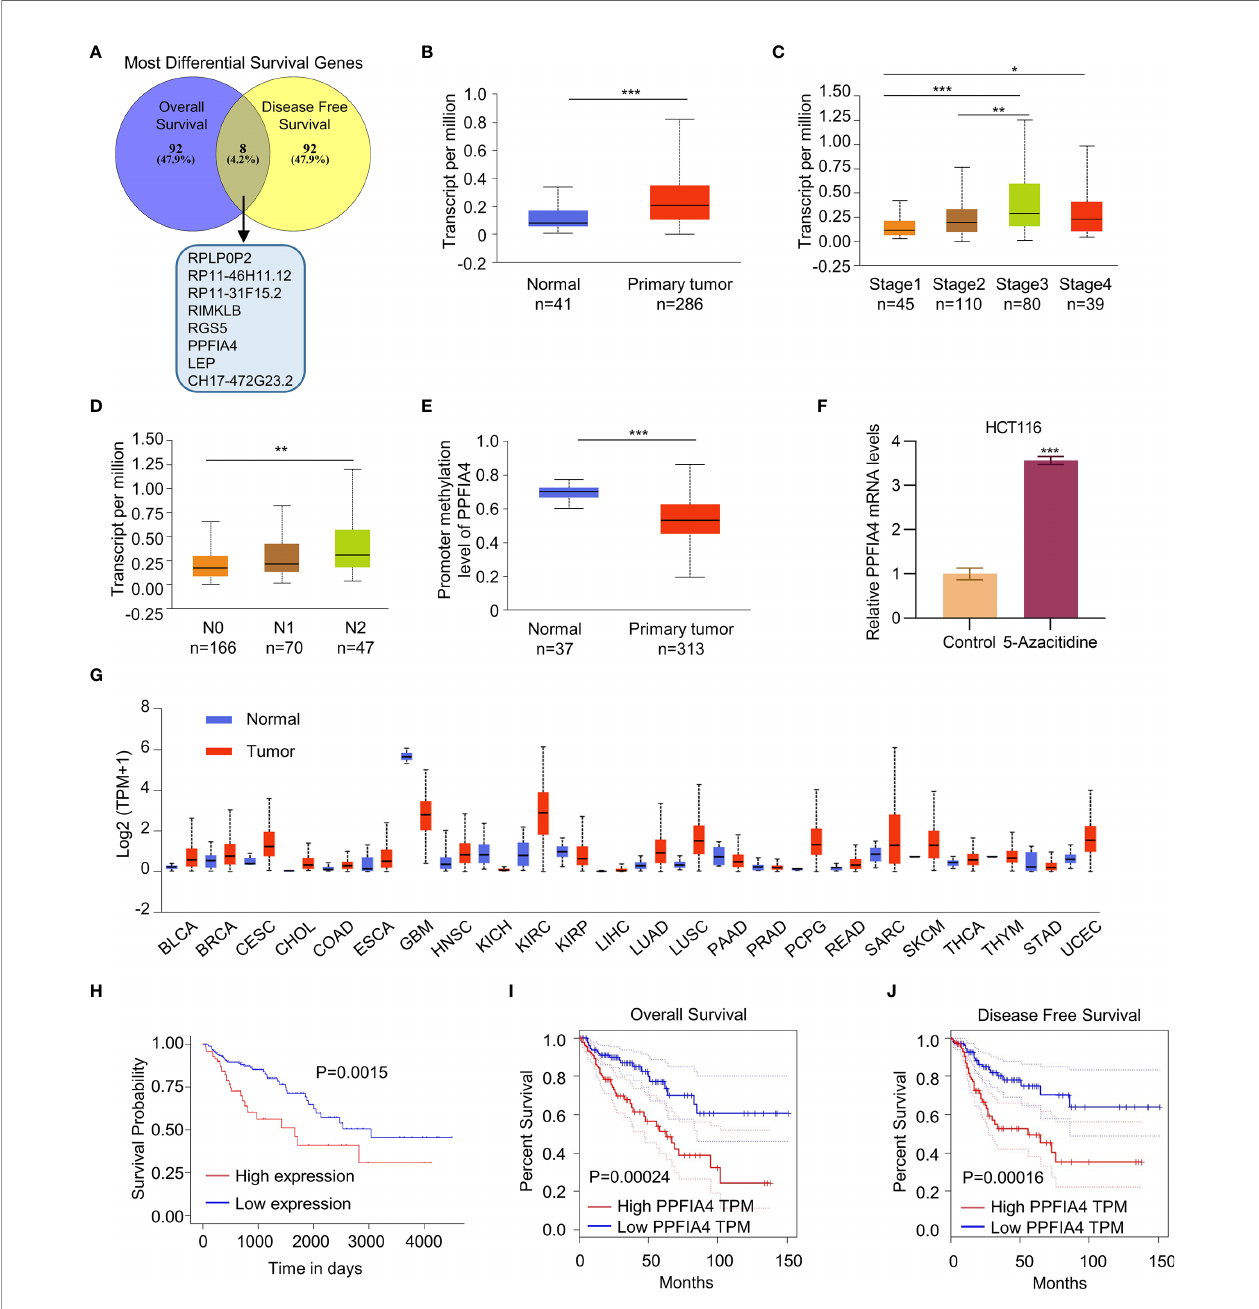
FIGURE 1 | PPFIA4 correlates with poor survival outcomes in colon cancer. (A) Venn diagram shows the union set of Most Differential Survival Genes in colon cancer patients in GEPIA datasets. (B) Expression of PPFIA4 in normal and colon adenocarcinoma tissues in TCGA datasets. (C) Expression of PPFIA4 in colon adenocarcinoma patients with different tumor stages in TCGA datasets. (D) Expression of PPFIA4 in colon adenocarcinoma tumor tissues with different metastatic stages in TCGA datasets. (E) The methylation levels of PPFIA4 in normal and colon adenocarcinoma tumor tissues were analyzed in TCGA datasets. (F) The mRNA levels of PPFIA4 in HCT116 cells treated with 5-Azacytidine were determined by qPCR. (G) Kaplan – Meier plots of overall survival in colon adenocarcinoma patients strati fi ed according to their PPFIA4 levels in TCGA datasets. (H) Expression of PPFIA4 across TCGA cancers with tumor and normal samples. (I) Analysis of overall survival of colon cancer patients using Kaplan – Meier plots. The patients were strati fi ed according to their PPFIA4 levels in GEPIA datasets. (J) Analysis of disease- free survival in colon cancer patients using Kaplan – Meier plots. *p < 0.05, **p < 0.01, ***p <